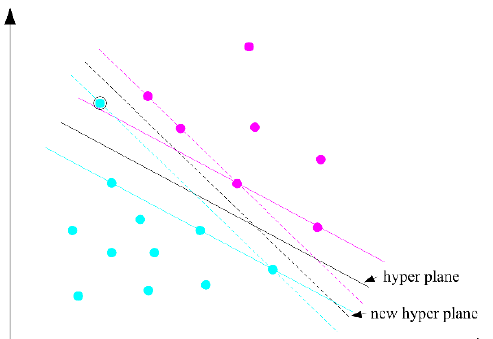
Figure 6 Schematic diagram of SVM model